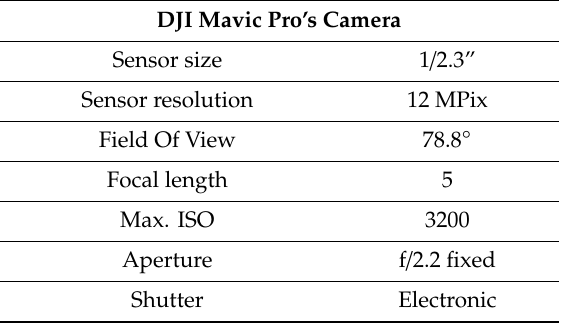
Table 5. Technical specifications of the camera used during the